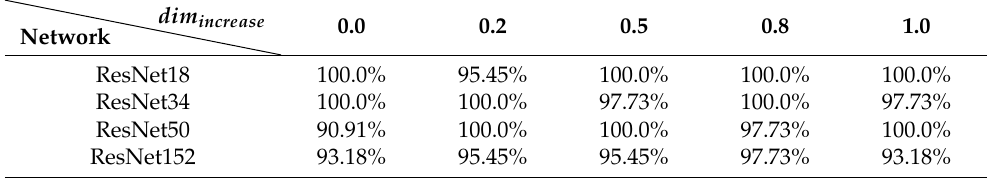
Table 6. Accuracy of the validation set with different combinations of network architecture and dim increase parameters for the dataset without human demonstration.